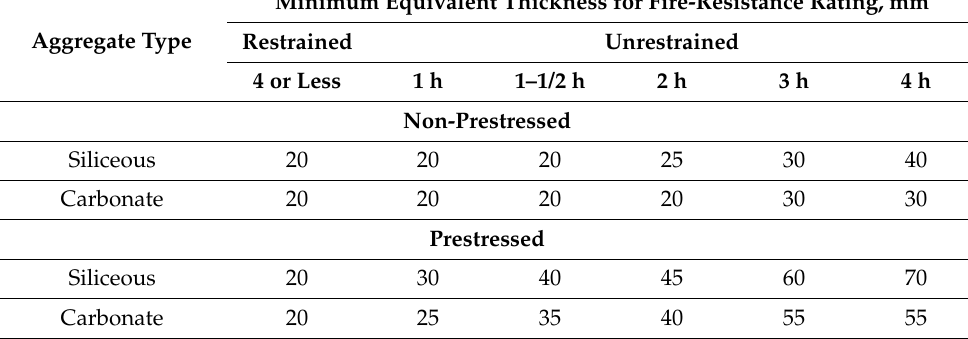
Table 7. Minimum cover in concrete floors and roof slabs (ACI 216.1M-14